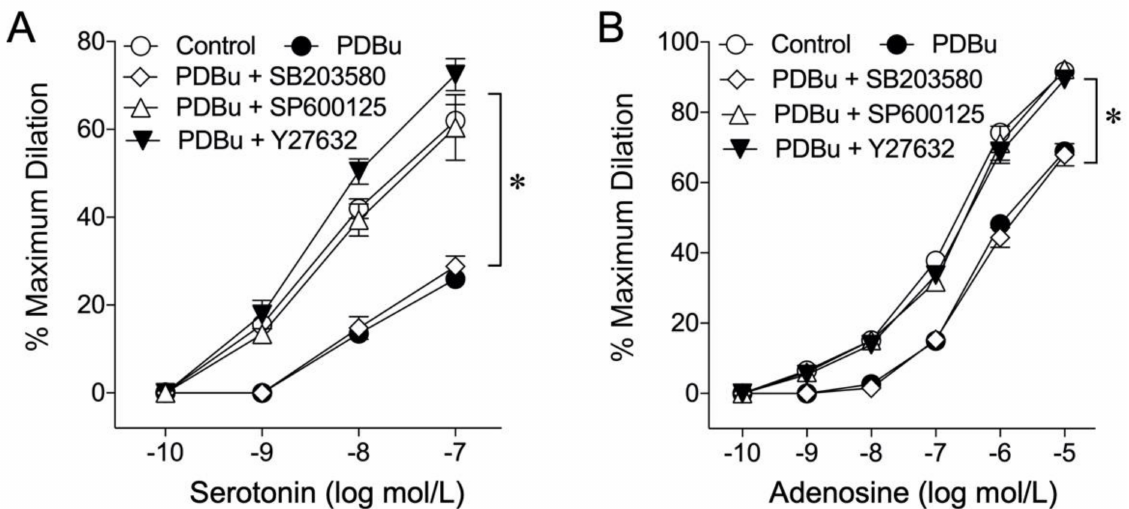
Figure 6. Role of kinases in the adverse effect of PKC activation. In the presence of the JNK inhibitor SP600125 (5 µ mol/L, n = 5) or Rho kinase inhibitor Y-27632 (0.1 µ mol/L, n = 5), but not p38 kinase inhibitor SB203580 (0.1 µ mol/L, n = 5), the adverse effect of PDBu on vasodilations in response to serotonin ( A ) and adenosine ( B ) was prevented. * p < 0.05 vs. the control, two-way repeated measures ANOVA with Tukey’s multiple comparison